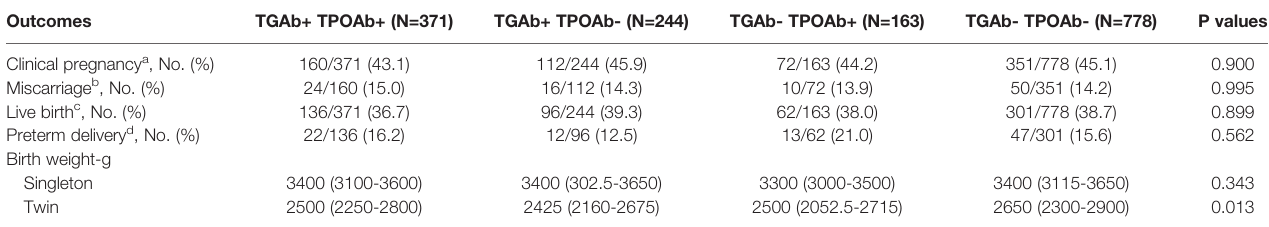
TABLE 6 | Subgroup analysis for pregnancy outcomes according to TGAb/TPOAb.